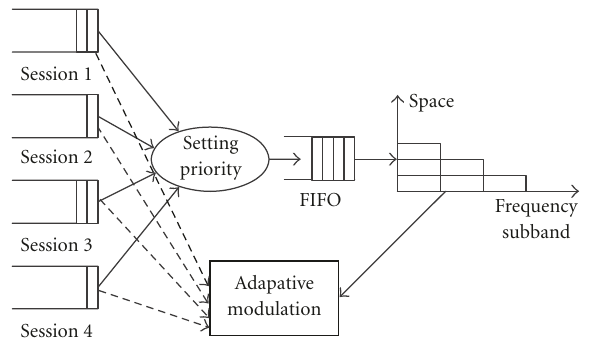
Figure 3: Description of